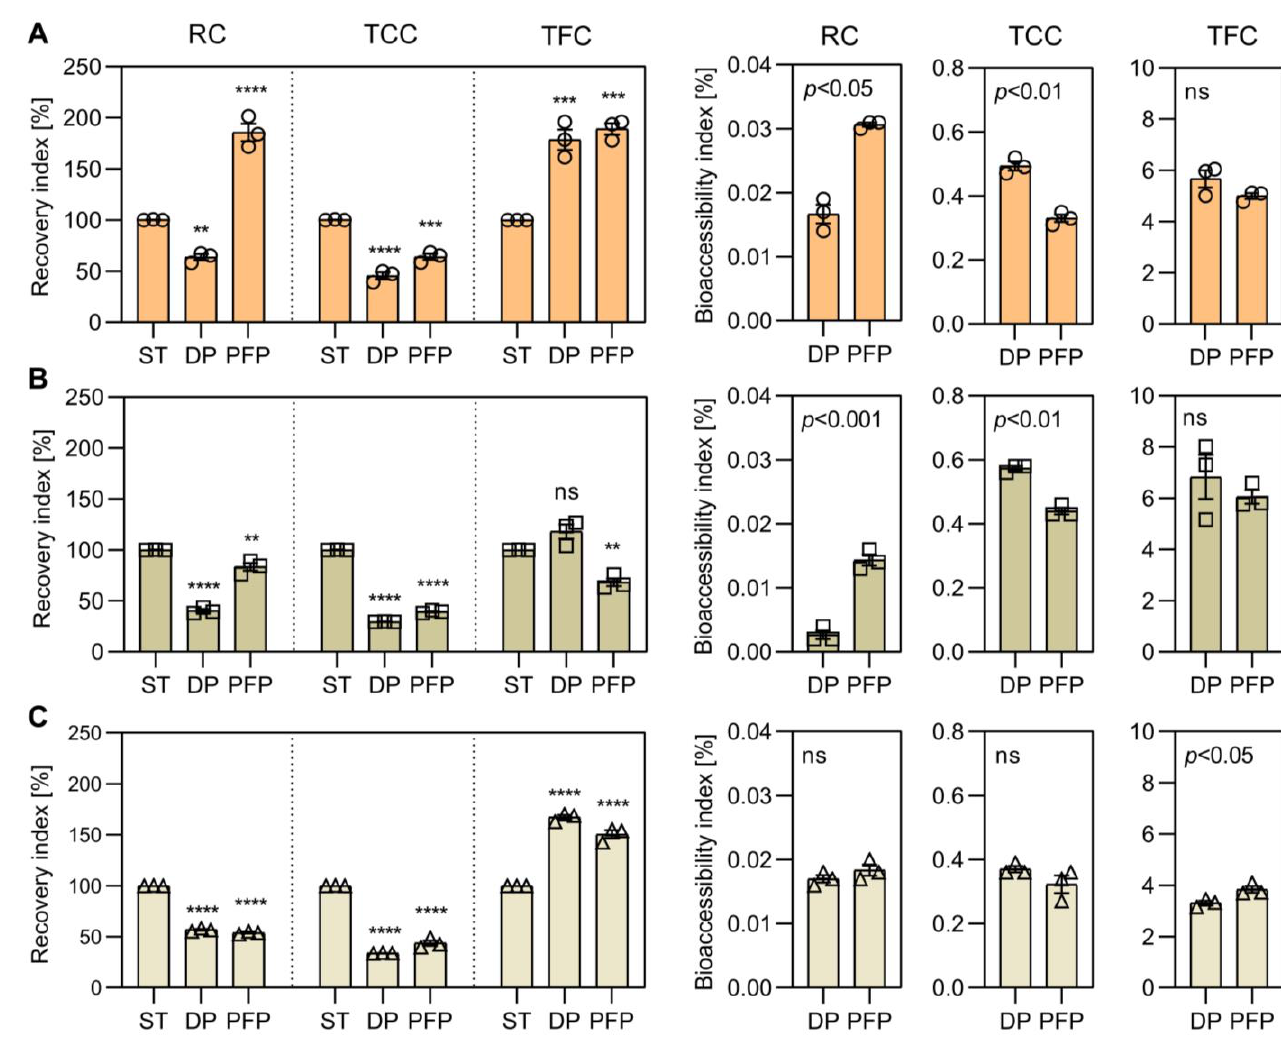
Figure 2. Recovery and bio-accessibility indexes of bonded total phenolic (TPC), total carotenoid (TCC) and total flavonoid content (TFC) in persimmon fiber (PF) after solvent treatment (ST), in vitro digestion (DP) and probiotic fermentation (PFP) processes. Recovery and bio-accessibility of bonded bio-compounds in PF obtained by ( A ) aqueous extraction (PFAE, ( B ) ethanolic extraction (PFEE, (cid:3) ), and ( C ) acetonic extraction (PFAC, (cid:52) ) (recovery: **** p < 0.0001, *** p < 0.001, ** p <